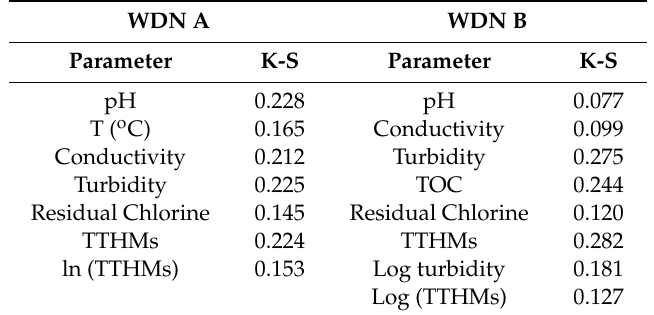
Table 3. Kolmogorov-Smirnov (K-S) values for the parameters of both